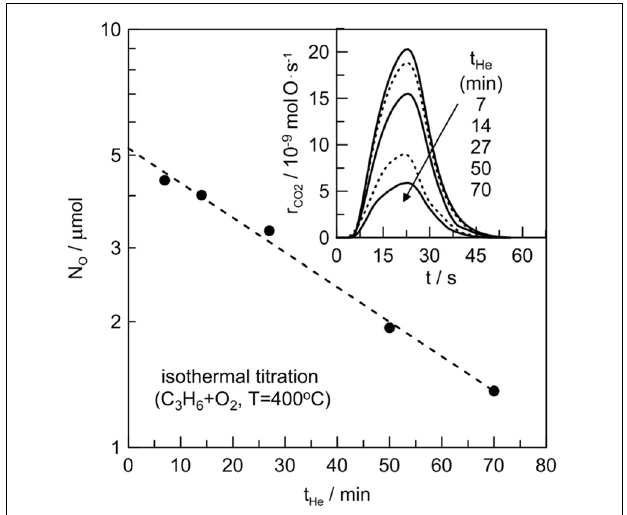
FIGURE 2 | Isothermal surface titration of oxygen by C 3 H 6 at 400 ◦ C. Effect of oxygen desorption time, t He , on the mass of reactive oxygen adsorbed on the Pt/ β (cid:2)(cid:2) -Al 2 O 3 (Ag + ) electrochemical catalyst. CO 2 peaks for each t He are also depicted in the